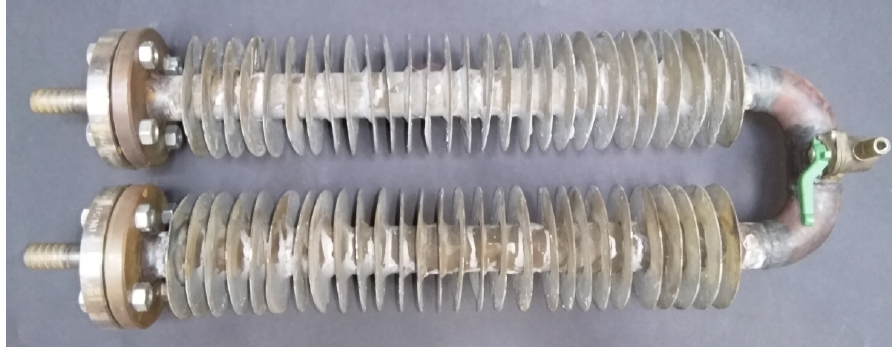
Figure 1. Investigated heat exchanger.